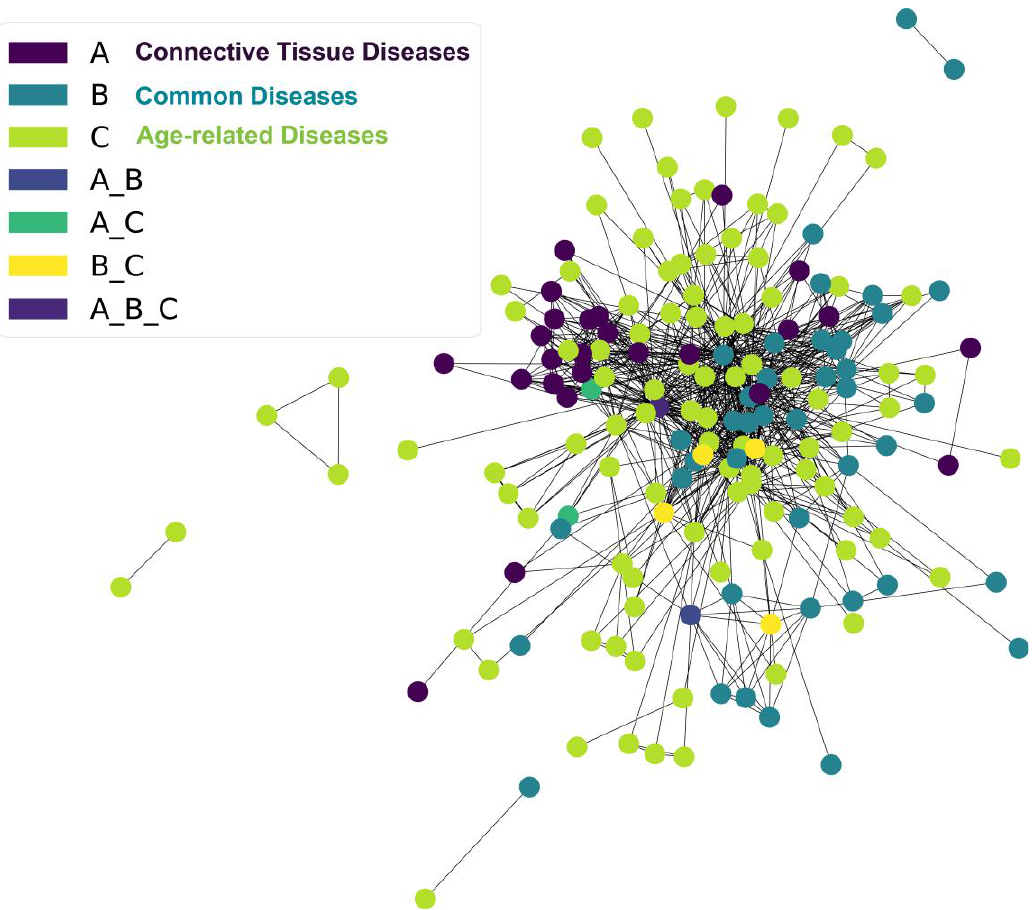
Figure 5. Total Matrisome Disease–Gene Associations. Cluster analysis of matrisome disease-gene– associations, composed primarily of age-related diseases and overlapping categories. For further details, including a graphical representation with the labeling of diseases and a tabular view, please see Supplementary Table S9.